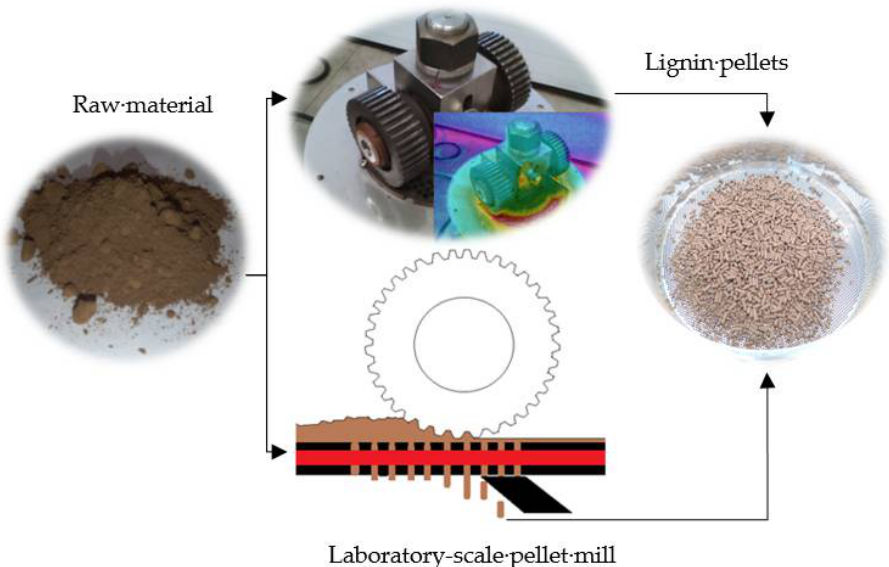
Figure 5. Pellet production process using the laboratory-scale pellet mill operated at the Biomass Technology Laboratory.